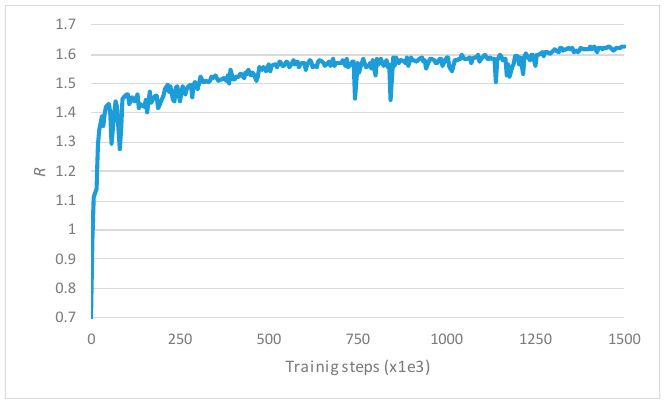
Sensors 2023 , 23 , x FOR PEER REVIEW 17 of 19